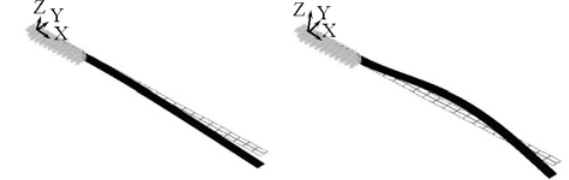
Figure 5. Mode shapes (1 st and 2 nd Flexural Mode).